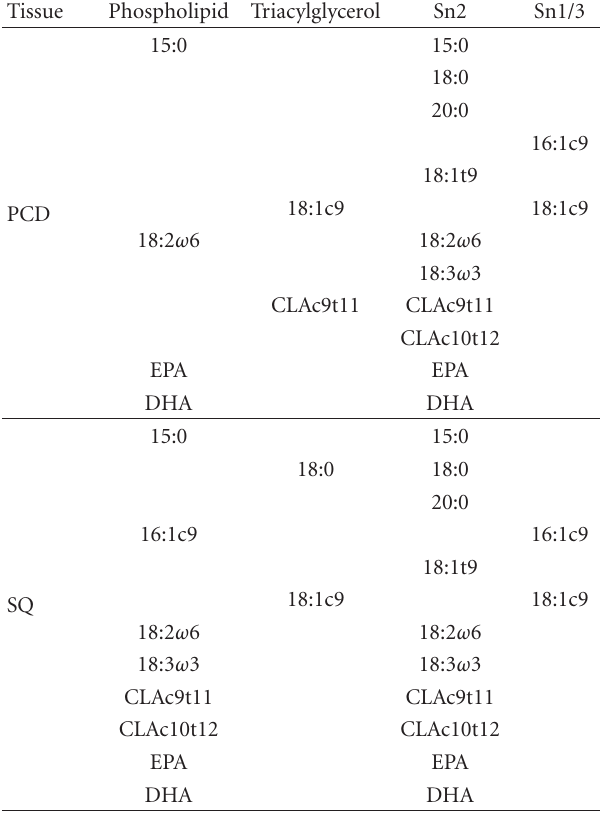
Table 6: Summary table of the principal location of occurrence of the fatty acids in fat from the pars costalis diaphragmatis (PCD) muscle and the subcutaneous (SQ) fat from the brisket of steers fed diets without or with n6 and n3 fatty